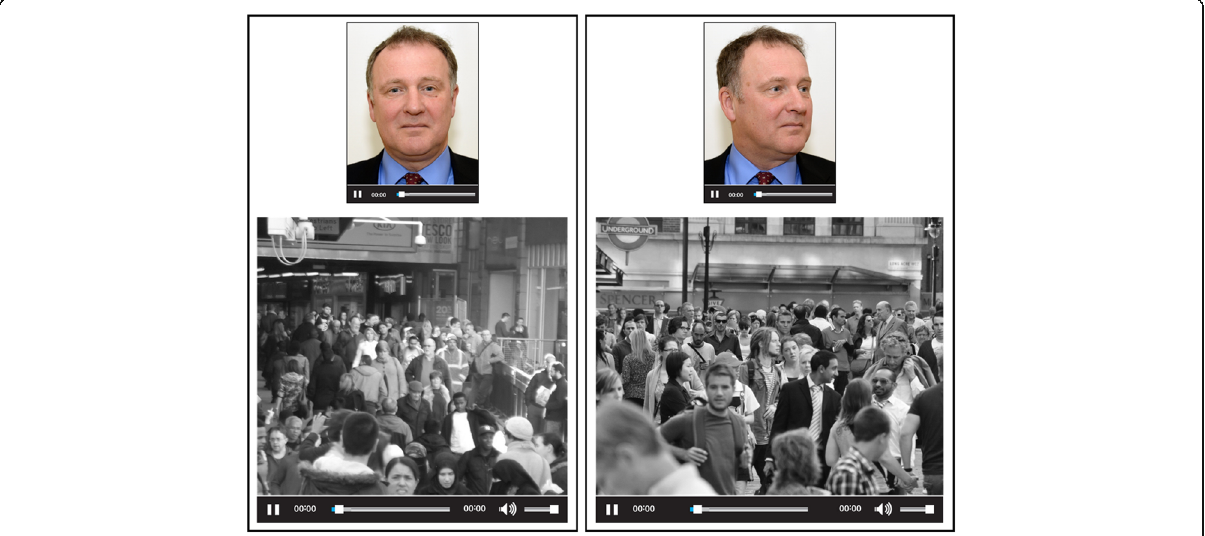
Fig. 5 Representation of two face-search trials, one in standard definition (left) and one in high definition (right). The search target at the top is from a video of the target. Legal restrictions prevent publication of the original target and closed-circuit television (CCTV) images. The target person shown here is a volunteer who has given permission for the images to be reproduced. See the attributions for the CCTV image in “ Acknowledgements